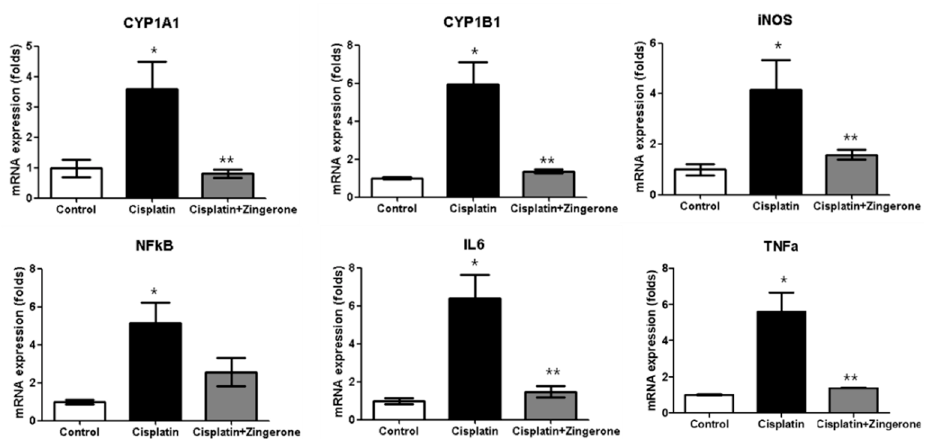
Figure 2. The mRNA expression levels of cytochrome P450 (CYP)1A1, CYP1B1, inducible nitric oxide synthase (iNOS), nuclear factor- κ B (NF κ B), tumor necrosis factor alpha (TNF α ), and interleukin 6 (IL6) were higher in the cisplatin (CXP) group than in the control group (* p < 0.05, ANOVA with CYP1A1, CYP1B1, iNOS, NF κ B, TNF α , and IL6 than the cisplatin group (** p < 0.05, ANOVA with